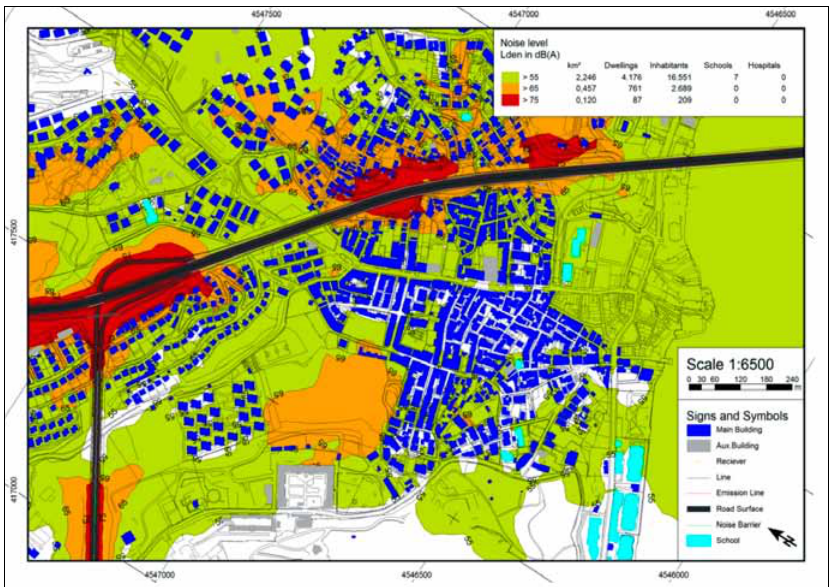
Fig. 3. Current situation statistical noise map for the day-evening-night average (L